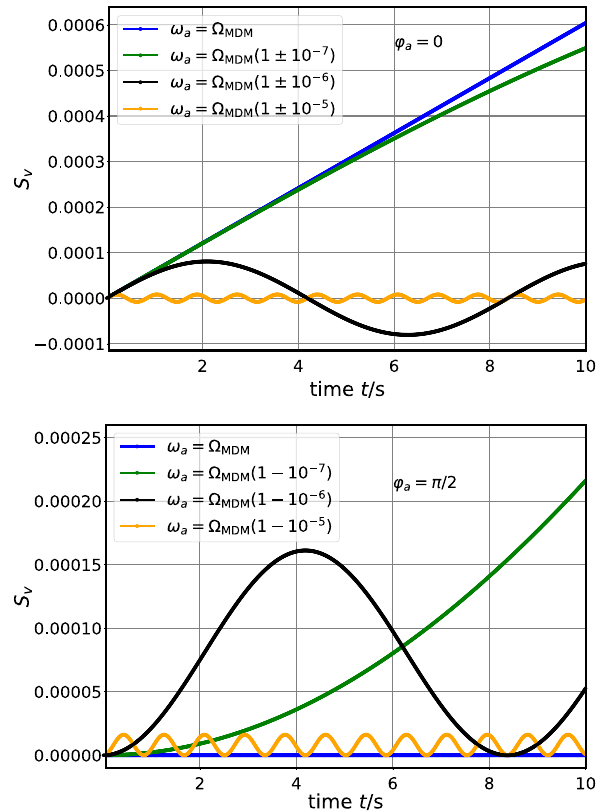
Fig. 2 Vertical spin component S v as a function of time t for ϕ a = 0 (upper plot) and ϕ a = π/ 2 (lower plot) and for different axion frequen- cies ω a and Ω MDM = 750 , 000 . 0s − 1 , Ω EDM ≈ 1 , 200 , 000s − 1 , η 0 = 0, η = 10 − 1